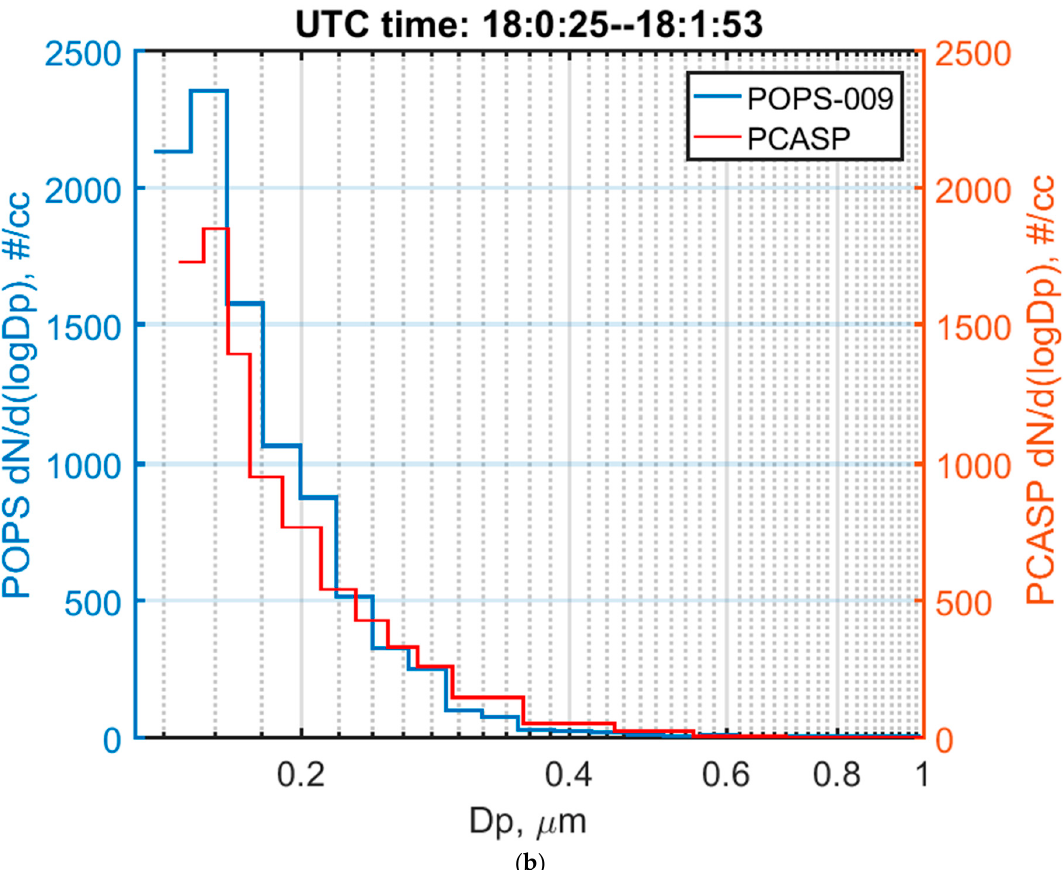
Figure 9. Comparison between POPS and PCASP during a flight on 17 August 2016: ( a ) Time series plot of POPS and PCASP; ( b ) size distribution of POPS and